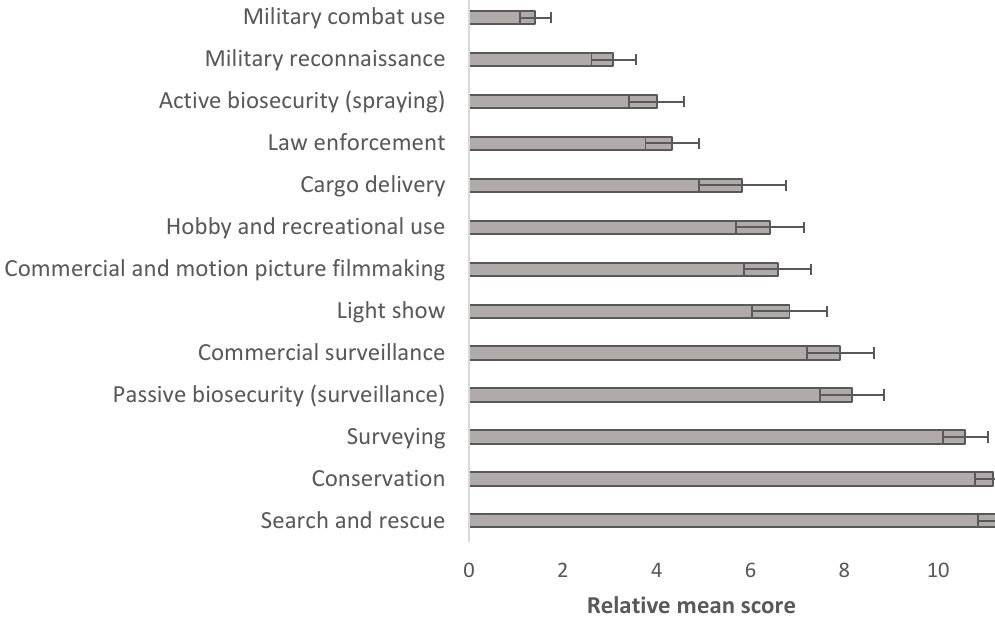
Figure 2. Relative mean score and standard error bars of how the category would be favoured by the public for each of the 13 UAV categories from 0 = least favourable to 12 = most favourable.